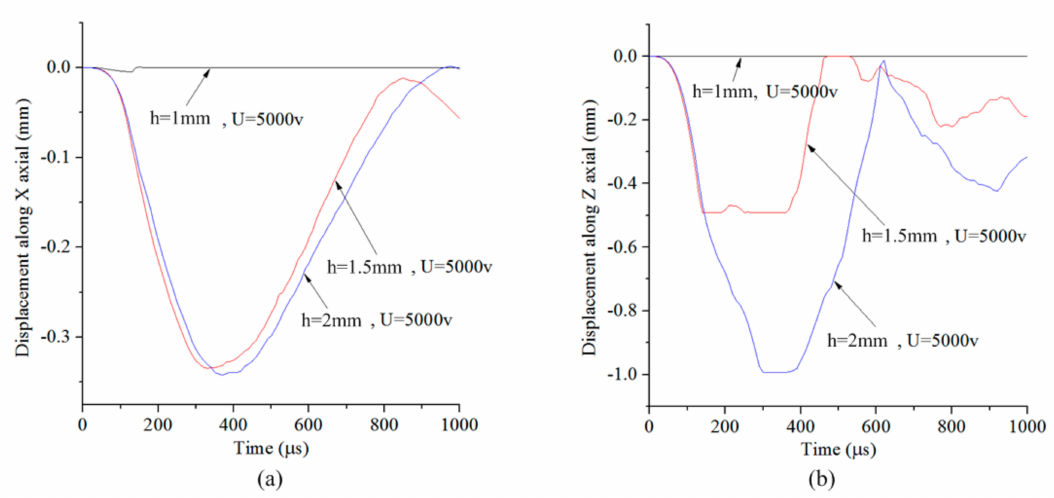
Figure 10. Displacement at node 3067 along ( a ) the X-axis and ( b )